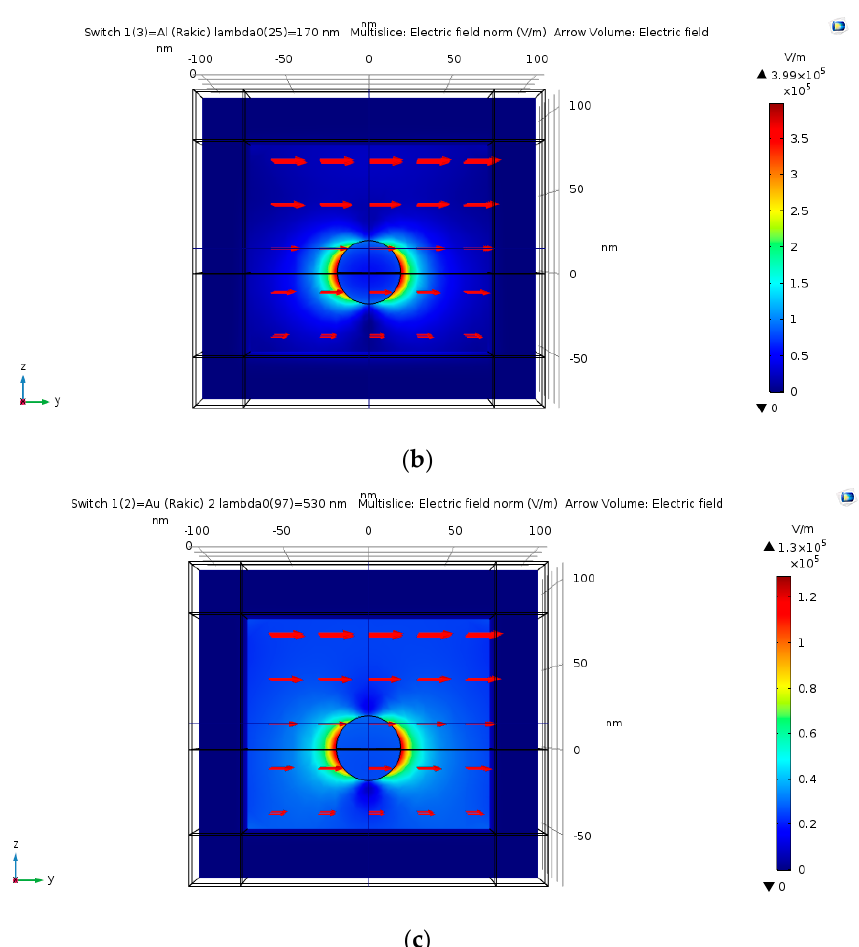
Figure 15. Simulations of silver ( a ), aluminum ( b ) and gold ( c ) nano-particle with the input of electric field in the Y direction and with k vector in the -Z direction.